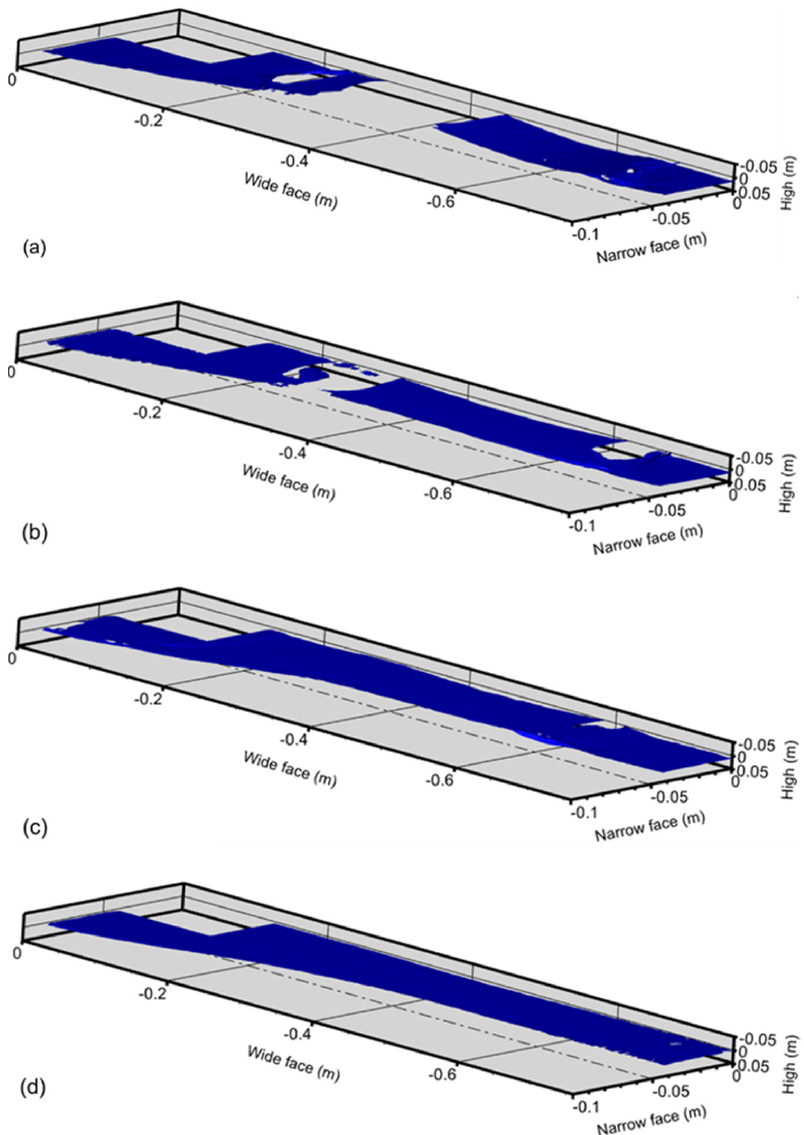
Figure 16. Slag entrapment situation at liquid-level. ( a ) No EMBr, ( b ) 300-200, ( c ) 800-600 and ( d ) 1100-800 A.